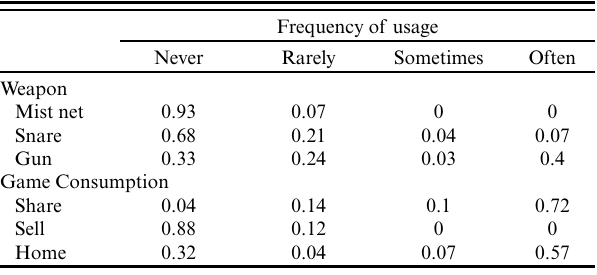
Table 1 . Frequency of usage for various weapons (Weapon) and consumption pathways (Game Consumption) for hunted game. Snares and guns are widely used. Most captured game is shared with friends (Share) or consumed at home (Home), rather than being sold at market (Sell). Frequency of usage denotes respondents who never, rarely, sometimes, or often engage in a particular activity.